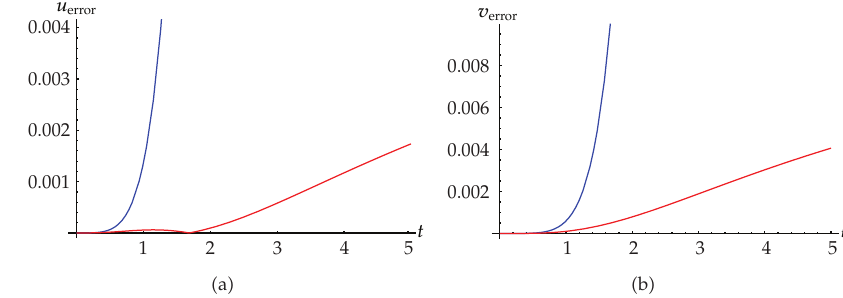
Figure 6: The absolute errors for the the GDTM solutions (cid:4) blue (cid:5) and the GDTM-Pad´e (cid:4) red (cid:5) of (cid:4) 1.2 (cid:5) when c (cid:8) 1, d (cid:8) 0 . 5 and n (cid:8) 5.